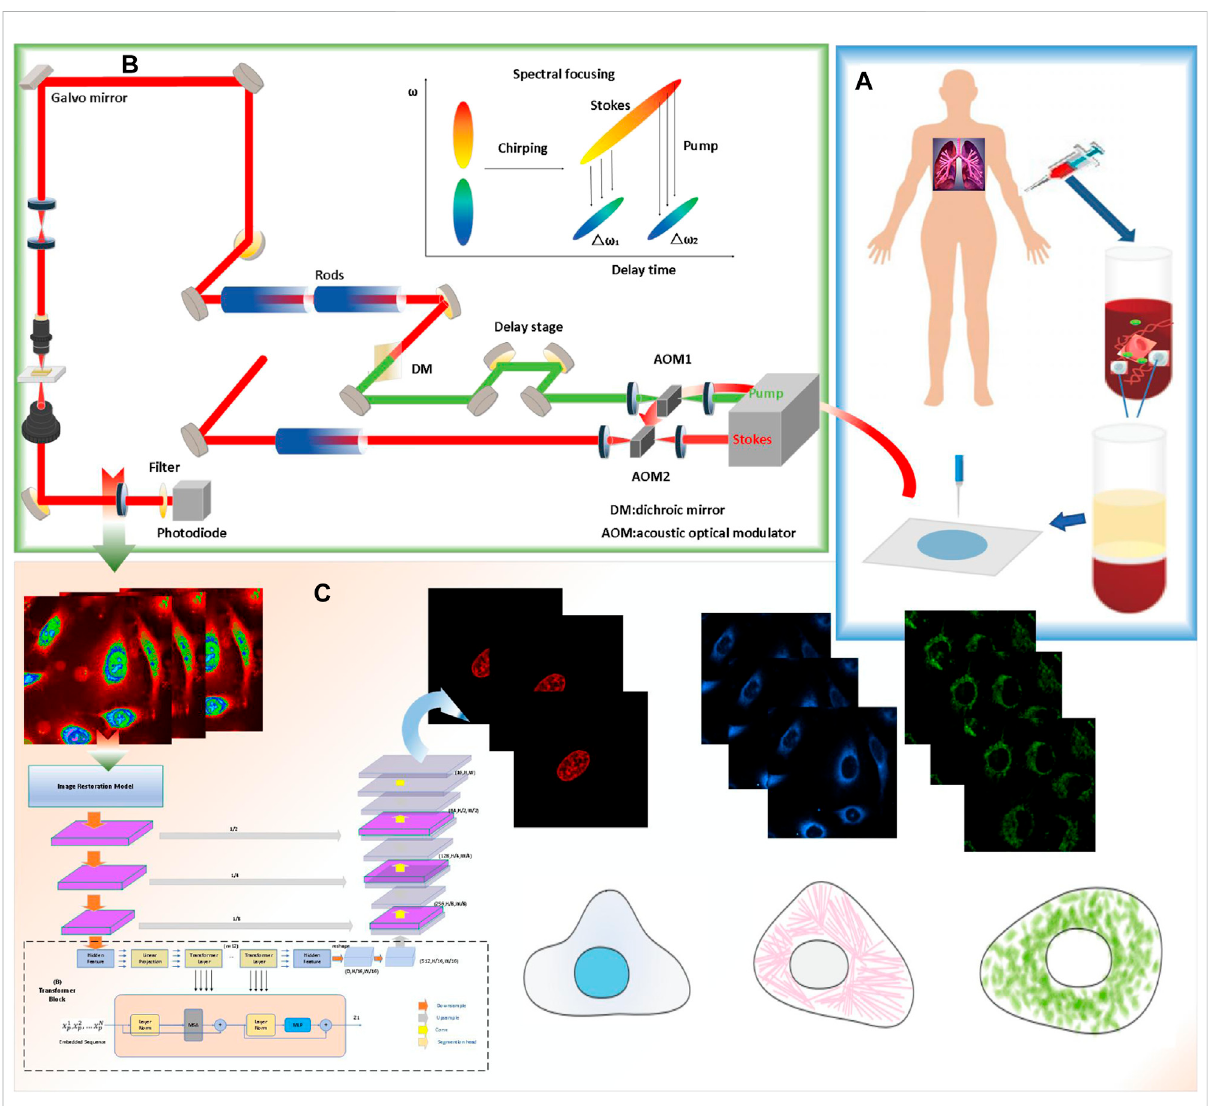
FIGURE 1 Work fl ow ofthesingle-cell analysis bystimulated Ramanscattering(SRS) imaging and deep-learning model prediction process. (A) cell